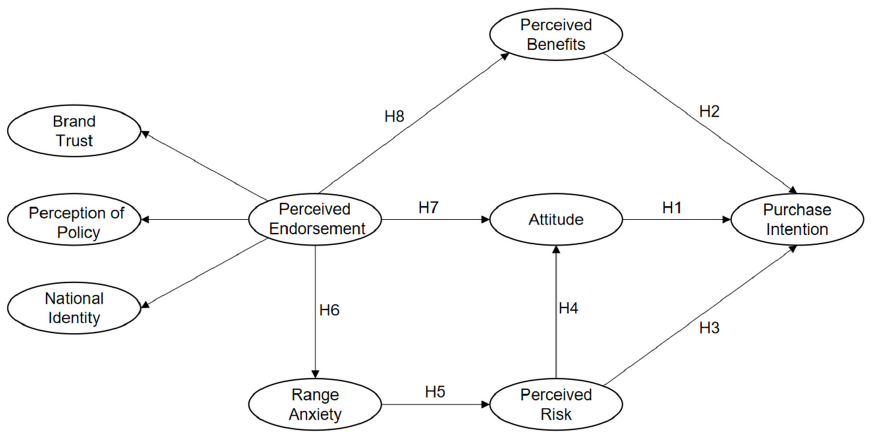
Figure 1. Research model. Source: author.